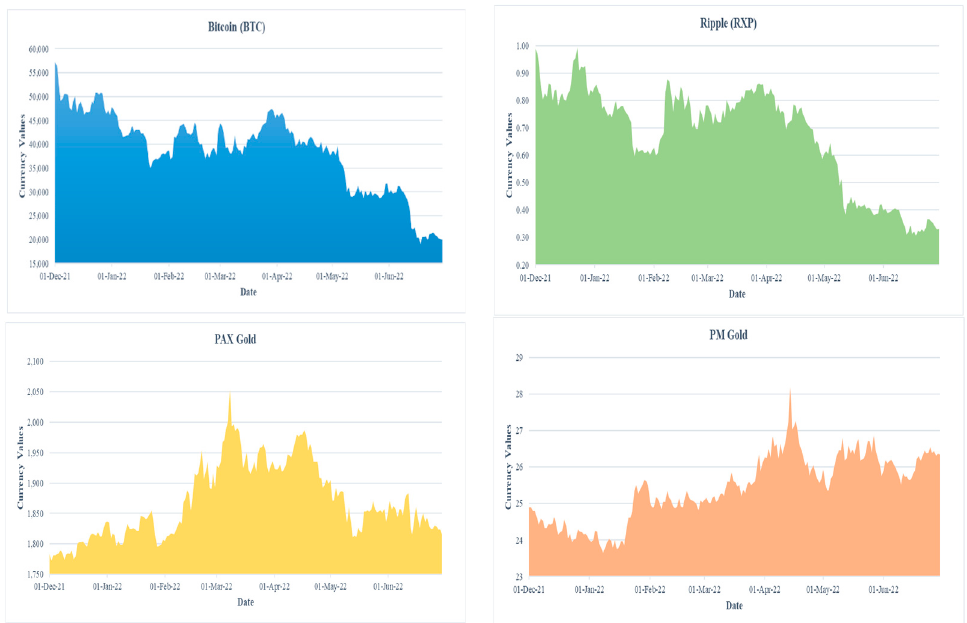
Figure 1. Fiat- and gold-backed